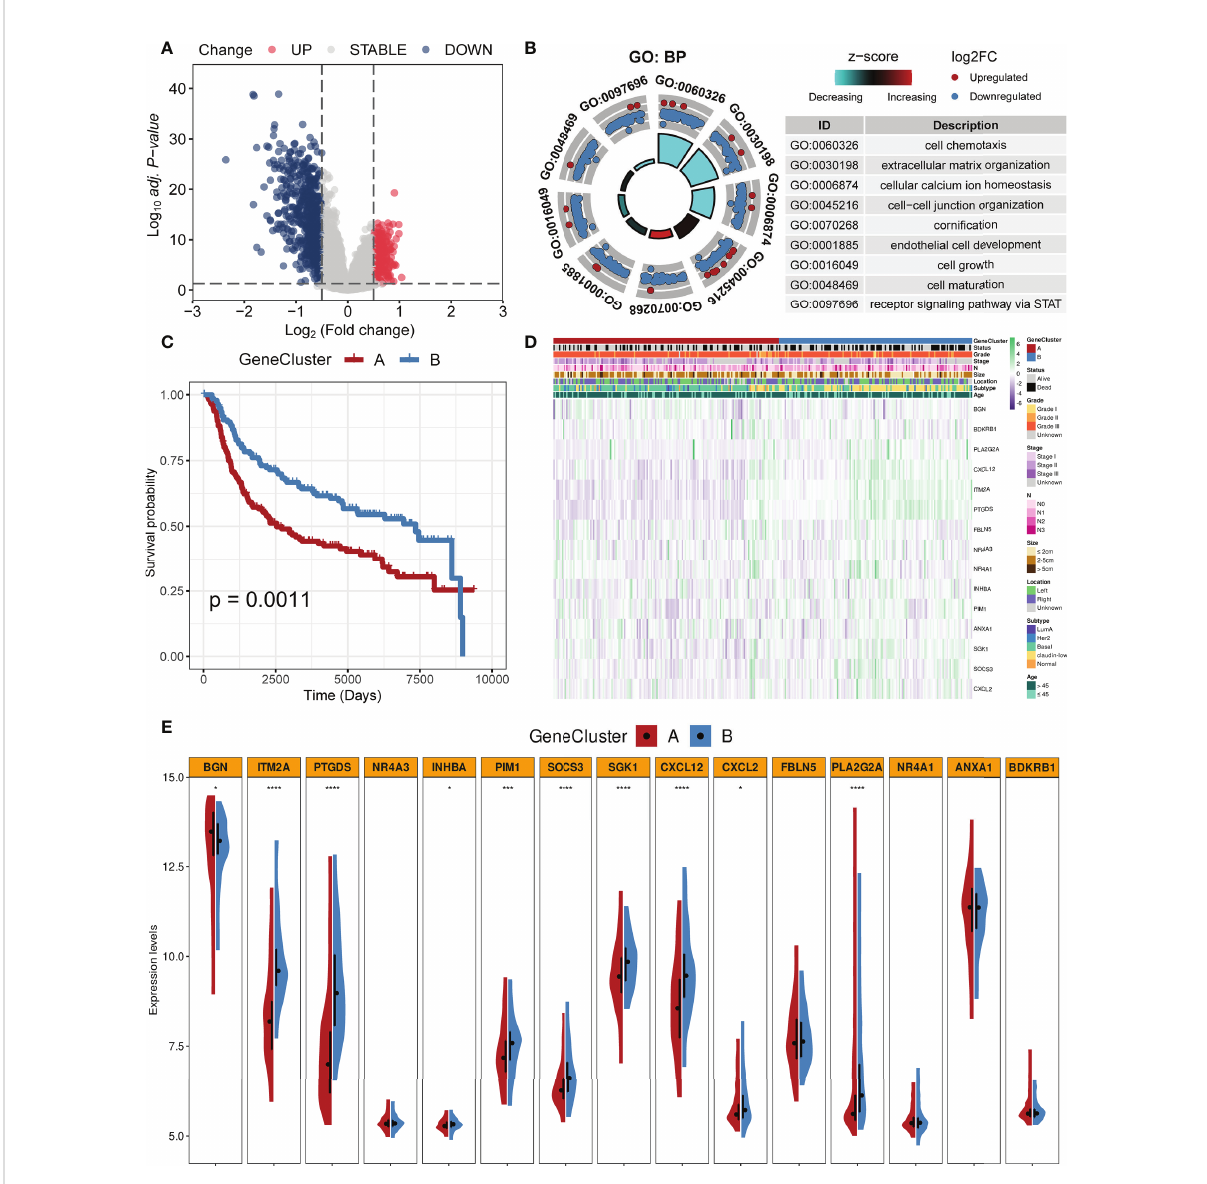
FIGURE 4 Identi fi cation of gene clusters based on the DEGs. (A) Volcano plot of DEGs between two clusters ( fi rebrick: upregulated; gray: not change; steel blue: downregulated). (B) GO enrichment analysis based on the DEGs. (C) K-M survival analysis of two gene clusters ( fi rebrick: gene cluster A; steel blue: gene cluster B). (D) Heatmap of two gene clusters with clinical features. (E) Violin plots of the expression levels of CAF-related genes in two gene clusters (****, ***, and * mean p < 0.0001, < 0.001, and < 0.05,